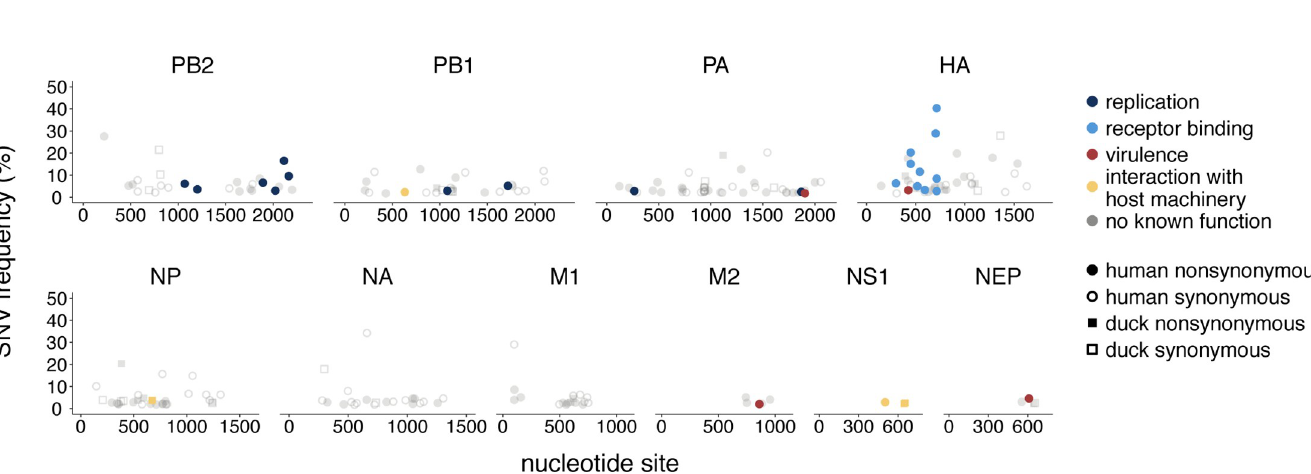
Fig 4. Mutations are present at functionally relevant sites. We queried each amino acid changing mutation identified in our dataset against all known annotations present in the Influenza Research Database Sequence Feature Variant Types tool. Each mutation is colored according to its function. Shape represents whether the mutation was identified in a human (circle) or duck (square) sample. Mutations shown here were detected in at least 1 human or duck sample. Filled in shapes represent nonsynonymous changes and open shapes represent synonymous mutations. Grey, transparent dots represent mutations for which no host-related function was known. Each nonsynonymous colored mutation, its frequency, and its phenotypic effect is shown in Table 3 , and a full list of all mutations and their annotations are available in S1 Table